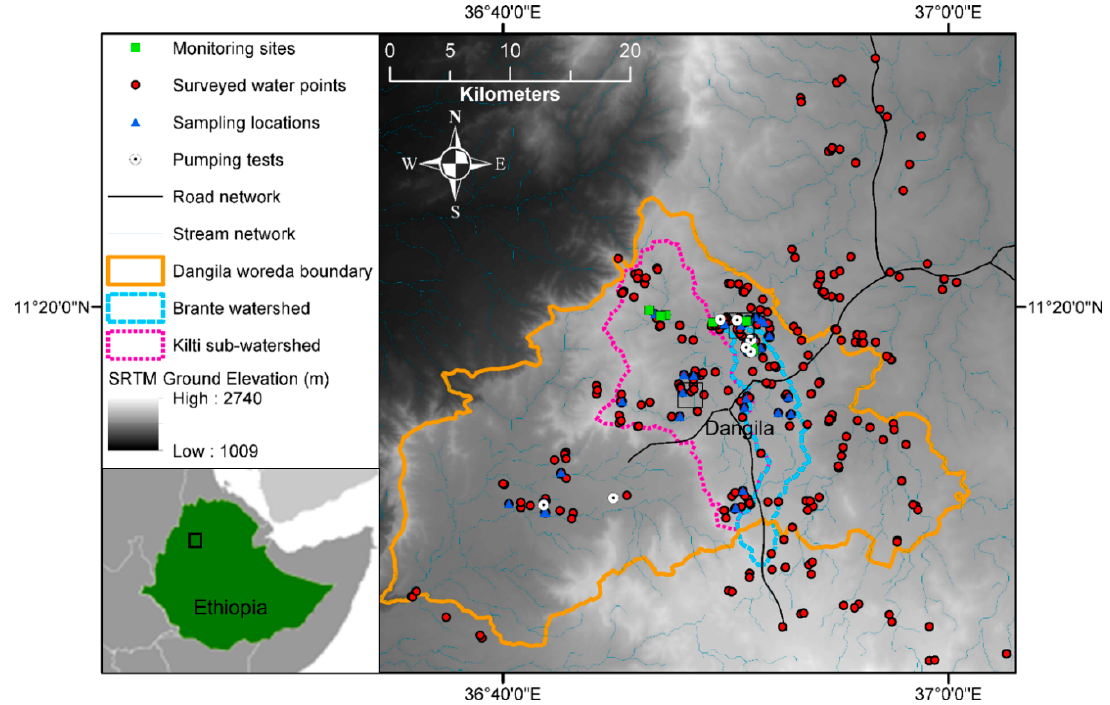
Figure 1. Location map of the study area showing monitoring sites, surveyed water points, and sampling locations. The black boxes show the locations of Figures 7a and 8b (eastern box) and Figure 8a (western box).